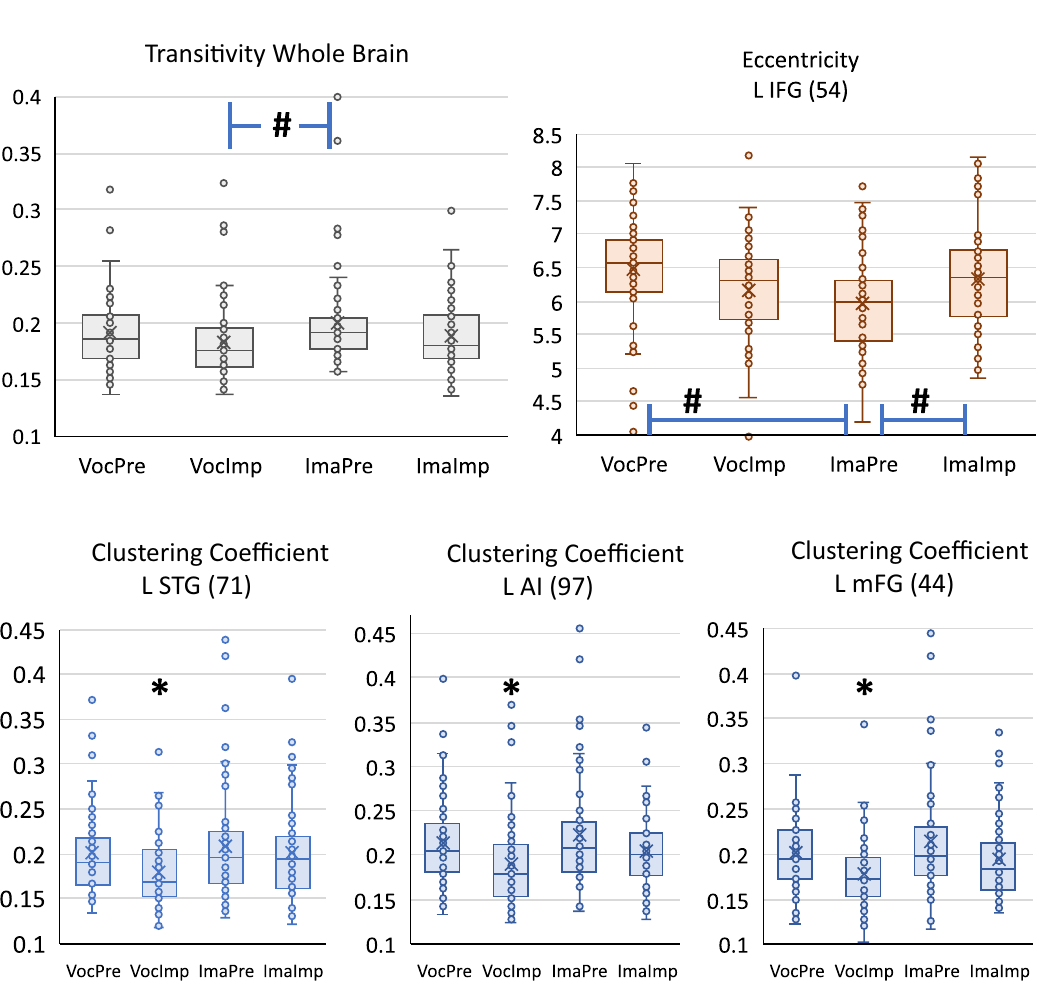
Figure 5. Significant group differences of graph metrics for each condition. Significant differences marked by an asterisk * indicate the lowest value among conditions. Significant differences marked as # indicate pair-wise comparisons over its corresponding line. Colors are meaningless and are used only to help differentiate among